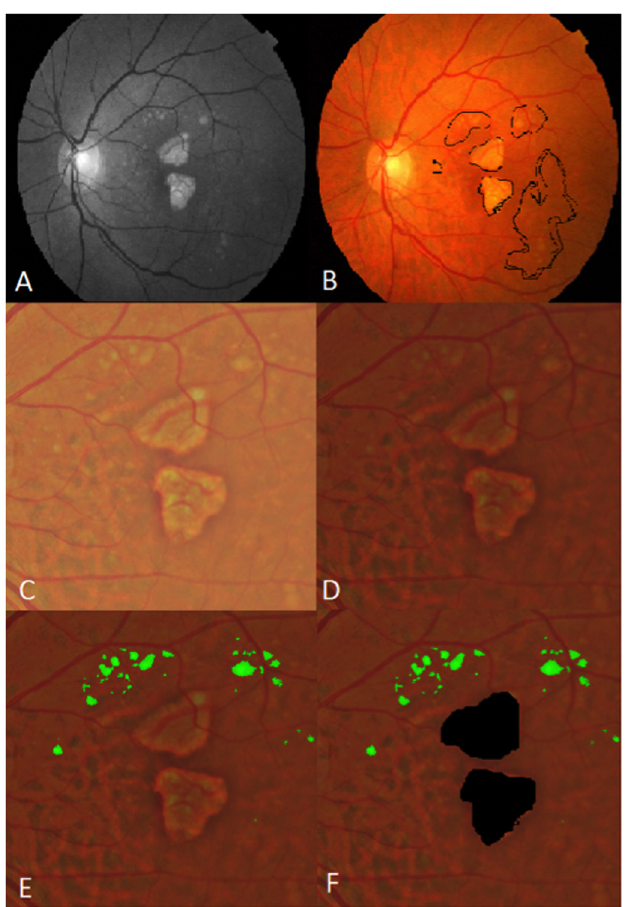
Fig 4. Segmentation of drusen and geographic atrophy (GA). A) Original red-free fundus photograph B) Original color fundus photograph with areas of drusen and GA outlined (black) C) Color fundus photograph cropped to 6 mm field. D) contrast enhanced color photo. E) segmentation of drusen (green) within the 6 mm field F) areas of GA masked